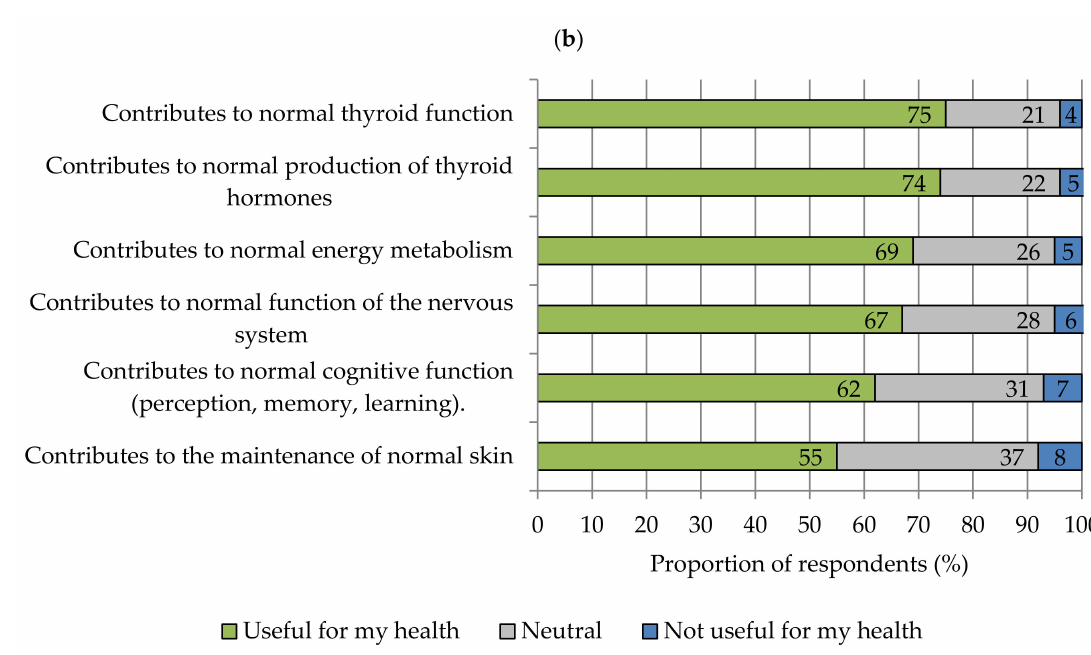
Figure 4. Acceptance of nutrition and health claims for iodine-rich fresh fruit and vegetables study. Participants were asked: ( a ) please rate the following labelling for iodine-biofortified fresh fruit and vegetables. n = 1016, and ( b ) please assess whether the following effects of iodine-biofortified fresh fruit and vegetables are personally useful to you. n = 508.